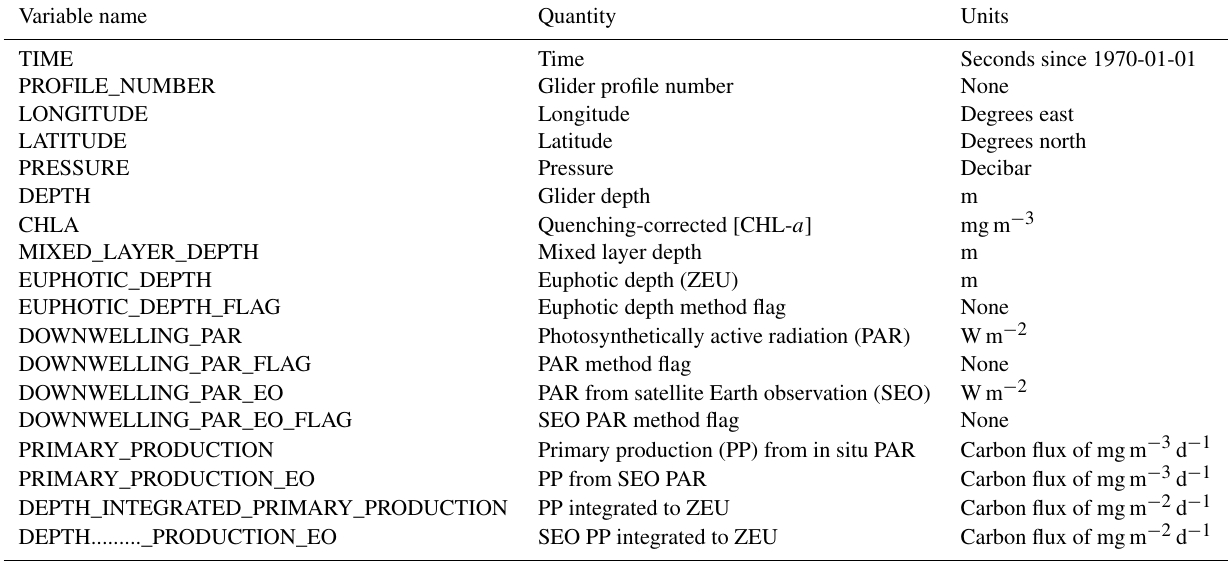
Table 4. Variables present in the EGO format netCDF data files. All variables have a single “time” dimension.